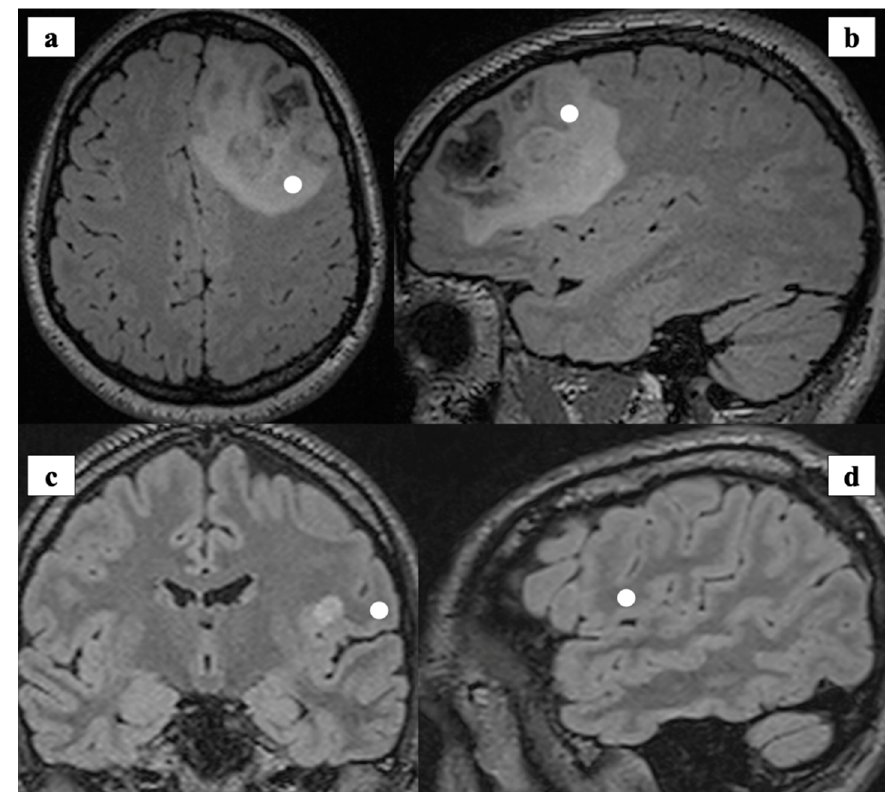
Figure 1. ( a , b ): Preoperative MRI (axial and sagittal view) showing tumor consistent with Anaplastic Oligodendroglioma IDH-1 mutant, 1p/19q co-deleted grade III (WHO 2016). The white spots show the intraoperative site of tissue biopsy registered with Neuronavigation system and labelled as tumor . ( c , d ): Preoperative MRI (axial and sagittal view) showing the intraoperative location of tissue collection that was labelled as healthy . The specimen was collected (white spot) and analyzed during the surgical approach to a peri-insular ganglioglioma (Grade I, WHO 2016).